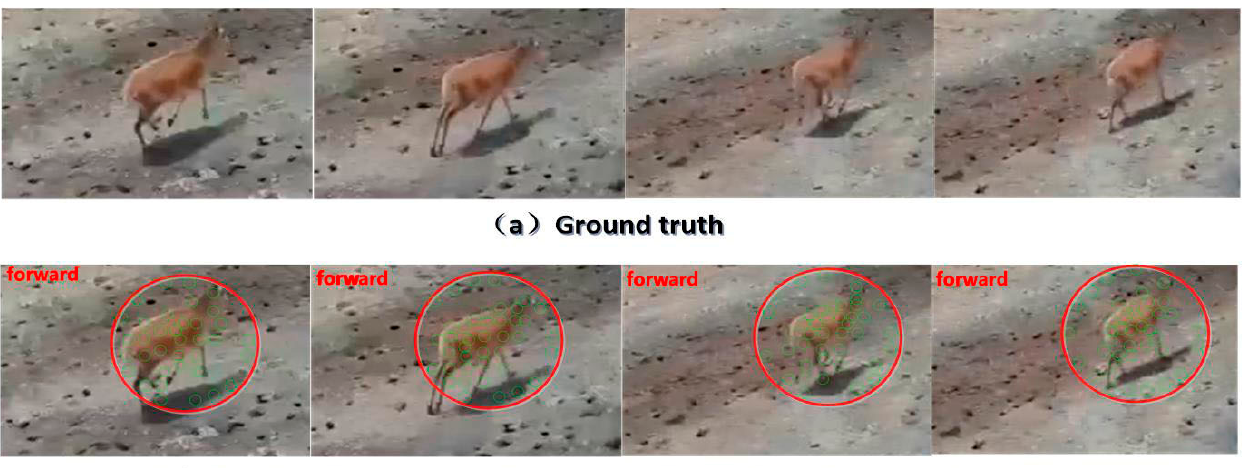
Figure 9. Computation for the motion direction of Tibetan antelopes in eight directions by the pro- posed algorithm. 5. Discussion Visualization like Figure 8 is important in determining the way to decide on the tracker skips. The decline in accuracy is mainly linear, but the reasoning time of the model exhibits a saturated decay return. The ideal skip is to achieve the required performance advantage without skipping more than the required number of times. Some test time char- acteristics of the model include 10 live frames, 1.2 scale factor ROI extended BB, and IoU- based association. The ROI BB can be adjusted adaptively according to the speed and frame rate of the object to be tracked. The faster the object moves, the farther it moves, and the larger the ROI regions. In contrast, slower objects need only a small ROI area. In this work, 1.2×is good for obtainingobjects, which can be adjusted based on the actual de- mands. This analysis turns off the frame display, object painting, and all other operations which are not necessary. This work demonstrates that the LB tracking shows no effect on the edge devices. Based on lots of previous tracking paradigms, this work is applicable for many various